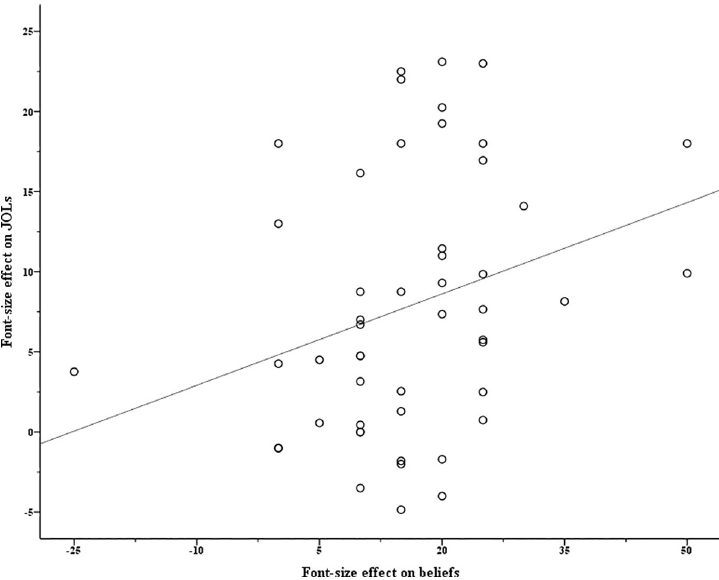
Fig 4. The relationship between the font size effects on beliefs and JOLs in Experiment 2’s low-frequency group.